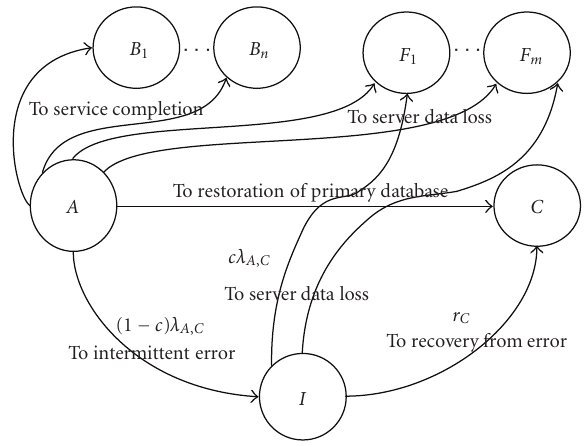
Figure 6: Decision error modeling with an intermittent error